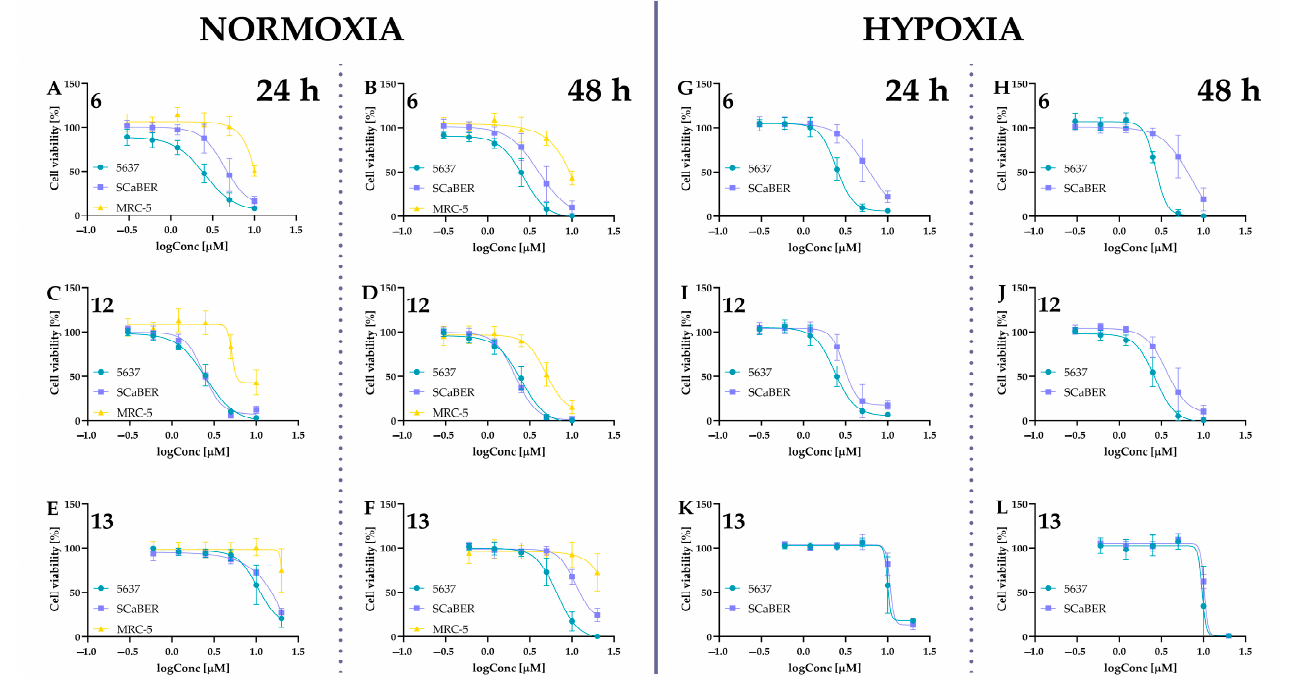
Figure 9. The dose-response curves plotted for compounds 6 , 12 , and 13 . Cell viability was measured using the MTT assay after 24 h and 48 h incubation under both normoxic and hypoxic (only for cancer cell lines) conditions. Panels ( A – F ) presents cell viability for 24 h and 48 h under normoxic conditions for compounds 6 ( A , B ); 12 ( C , D ) , 13 ( E , F ). Panels ( G – L ) presents cell viability for 24 h and 48 h under hypoxic conditions for compounds 6 ( G , H ); 12 ( I , K ), 13 ( K , L ). Cells were treated with isocurcumin derivatives ( 6 and 12 ) at a concentration of 0.3 µM, 0.6 µM, 1.2 µM, 2.5 µM, 5 µM, and 10 µM for 24 h and 48 h. The isocurcumin ( 13 ) was used at a concentration of 0.6 µM, 1.2 µM, 2.5 µM, 5 µM, 10 µM, and 20 µM. The DMSO was used as a control. The H35 Hypoxystation (Don Whitley Scientific, Bingley, UK) created controlled and precise hypoxic conditions (1% of oxygen). Data are presented as mean values ± SD calculated from at least two independent experiments.